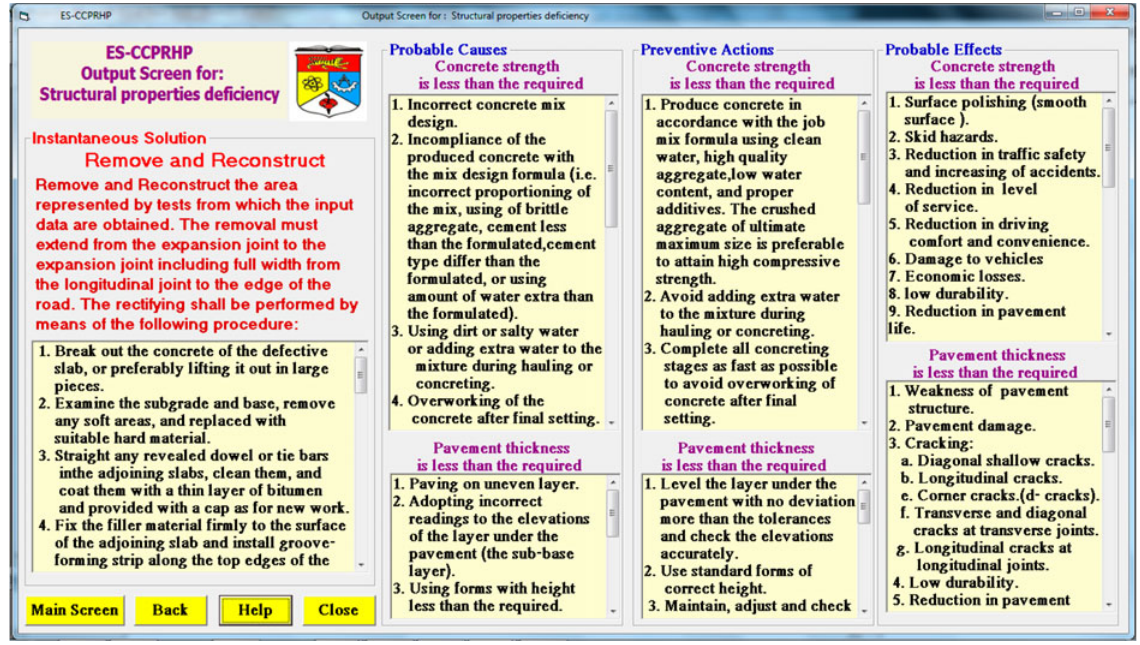
Fig. 5. ES-CCPRHP output screen for structural property de fi